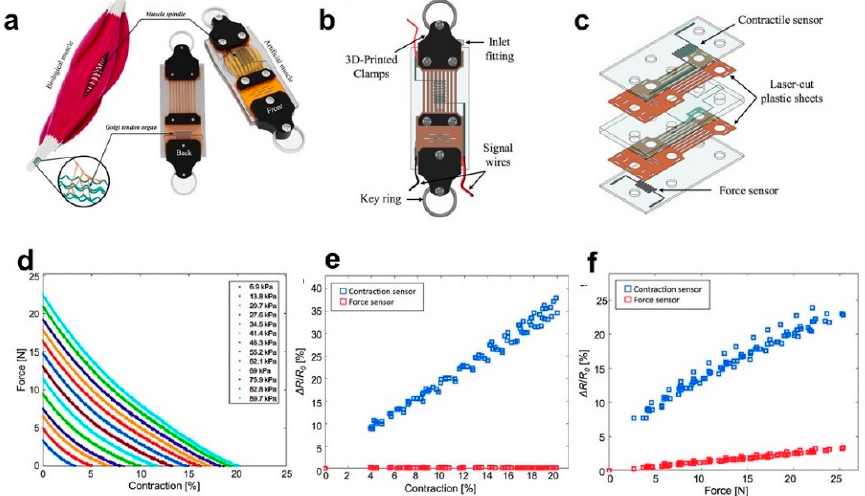
Figure 6. Typical models of artificial muscle and its sensor characteristics. ( a ) Schematic comparison of sFPAM (sensorized, flat, pneumatic artificial muscle) with biological muscle. ( b ) Illustration of the completed actuator at rest with labels designating key components. ( c ) Exploded view provides a clear visualization of the contraction and pressure sensors. ( d ) Force–contraction relationship at pressures ranging from 0 to 90 kPa. ( e ) The resistive response of force and contractile sensors due to contraction and ( f ) force [90]. Copyright (2019) Jackson Wirekoh et al., Published by Mary Ann Liebert, Inc.